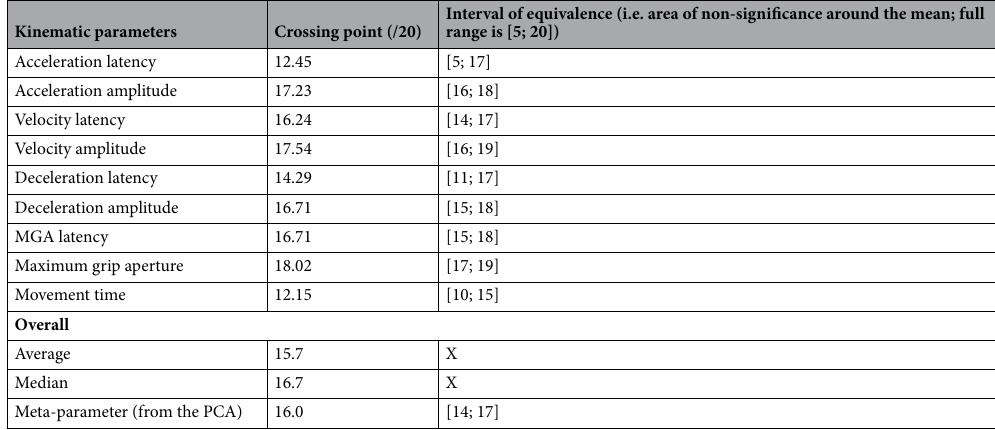
Table 2. Point and area around where there was no difference between PRE and POST, and after which a change in kinematic pattern occurred. PCA stands for Principal Component Analysis and indicates the overall crossing point when grouping all parameters, with its interval of equivalence. Puberty score ranges from 5 to 20.